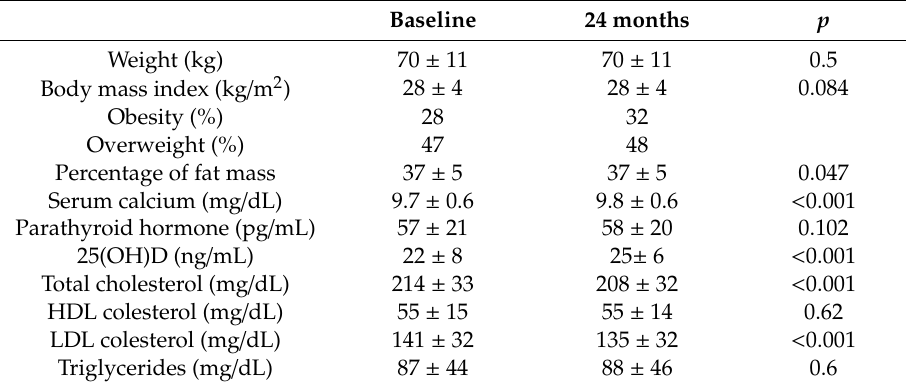
Table 1. Characteristics of study subjects at baseline and after 24 months of